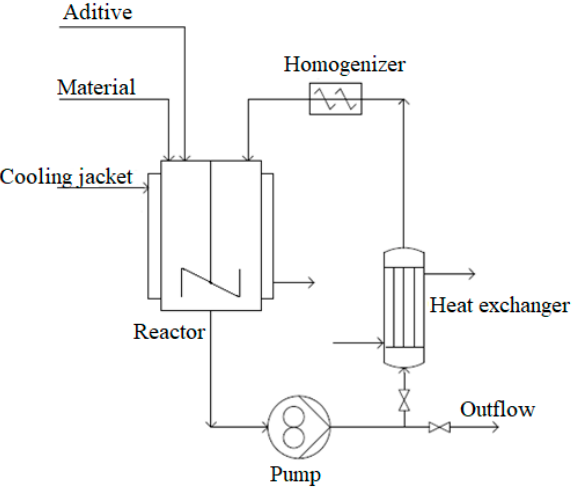
Figure 1. Proposed process